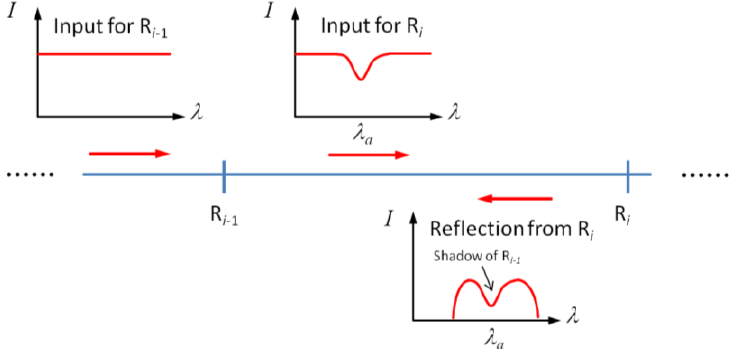
Figure 10. Spectral shadowing effect. The ( i − 1)th sensor has a spectral feature at  it casts a shadow on the i th sensor. As a result, the reflection from R information of R i −1